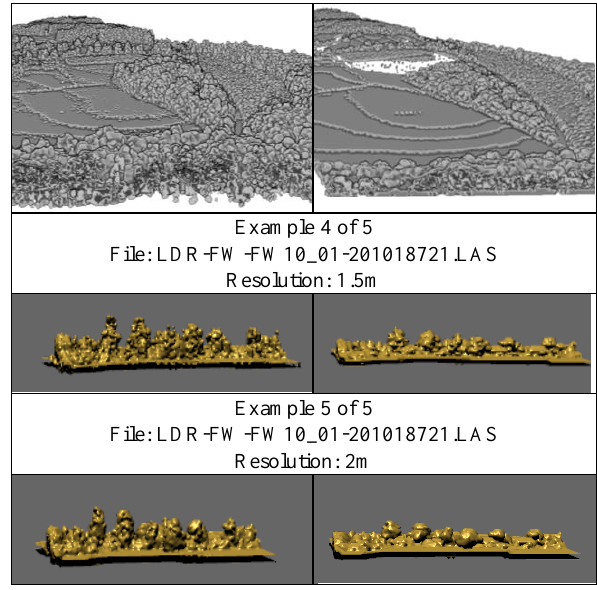
Table 3: Full-waveform versus discrete LiDAR